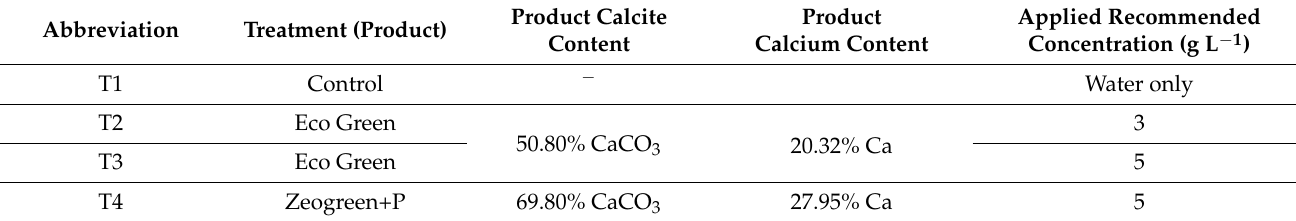
Table 2. Treatments used in the experiment.